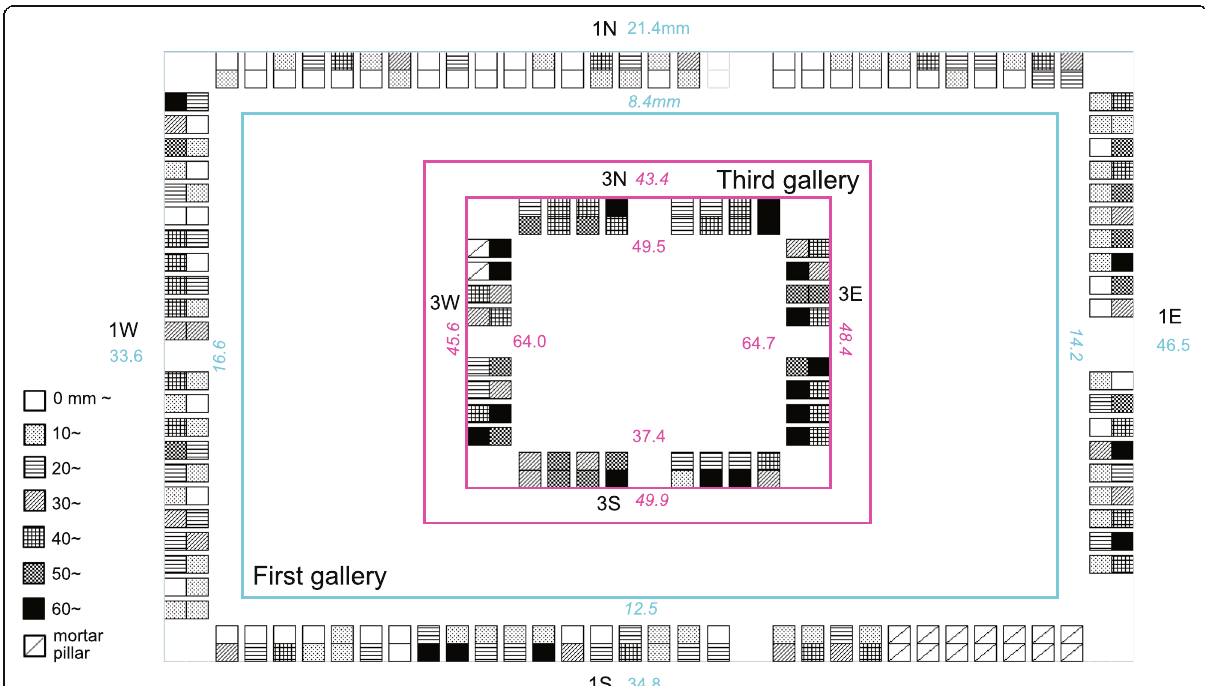
Fig. 5 Hollow depths of sandstone inner pillar at galleries of Angkor Wat temple. Numbers of upright and italic show the average depth of outer hollow and the average depth of inner hollow,